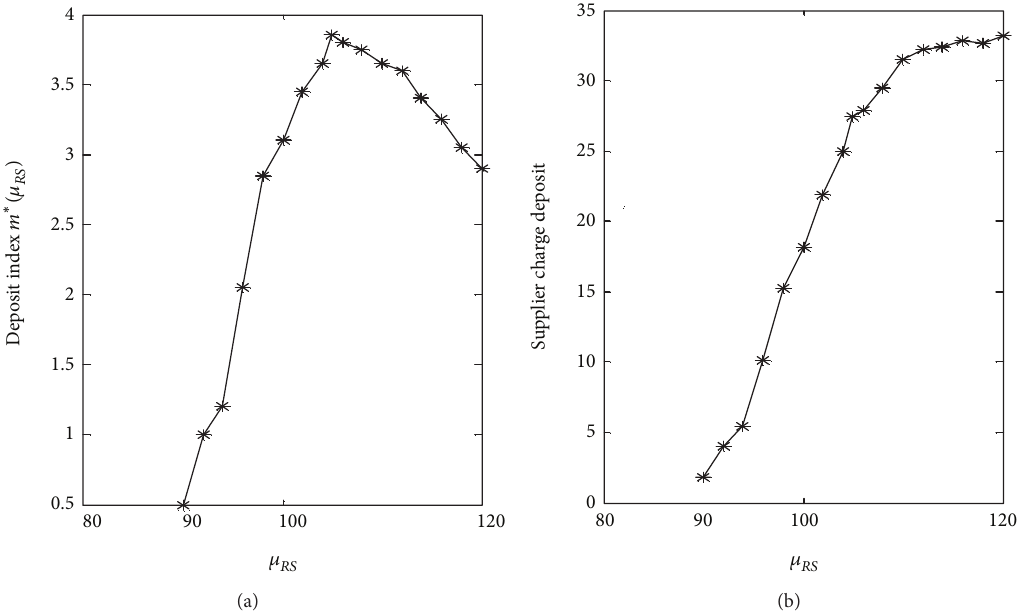
Figure 8: The optimal deposit index 𝑚 ∗ (𝜇 𝑅𝑆 ) and the supplier charged